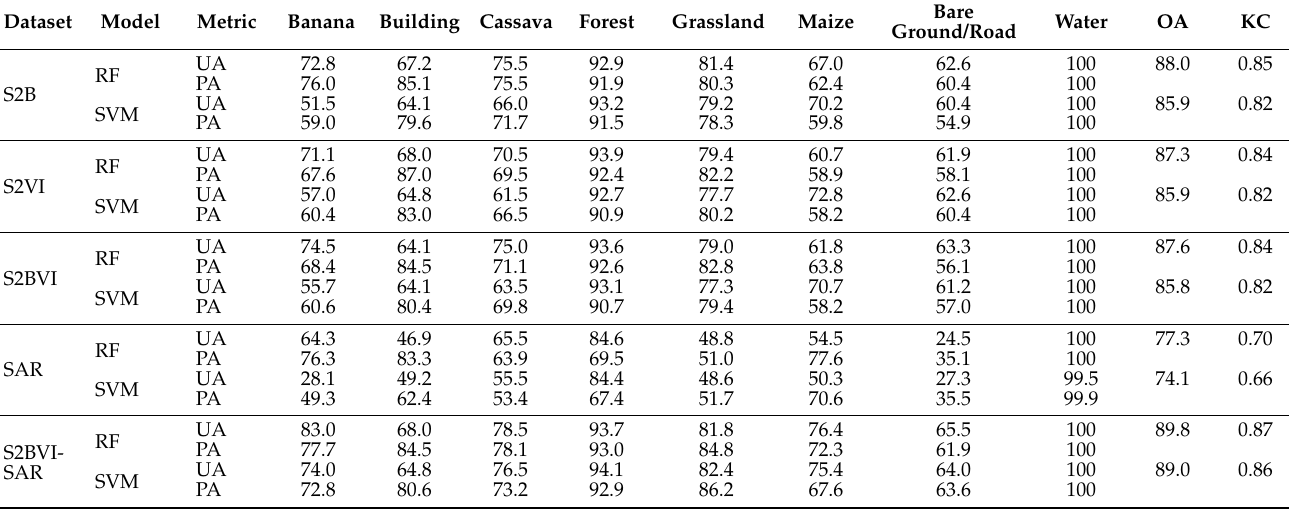
Table 8. User accuracy (UA) and producer accuracy (PA) of the Sentinel 2A and SAR integrated dataset experiments.